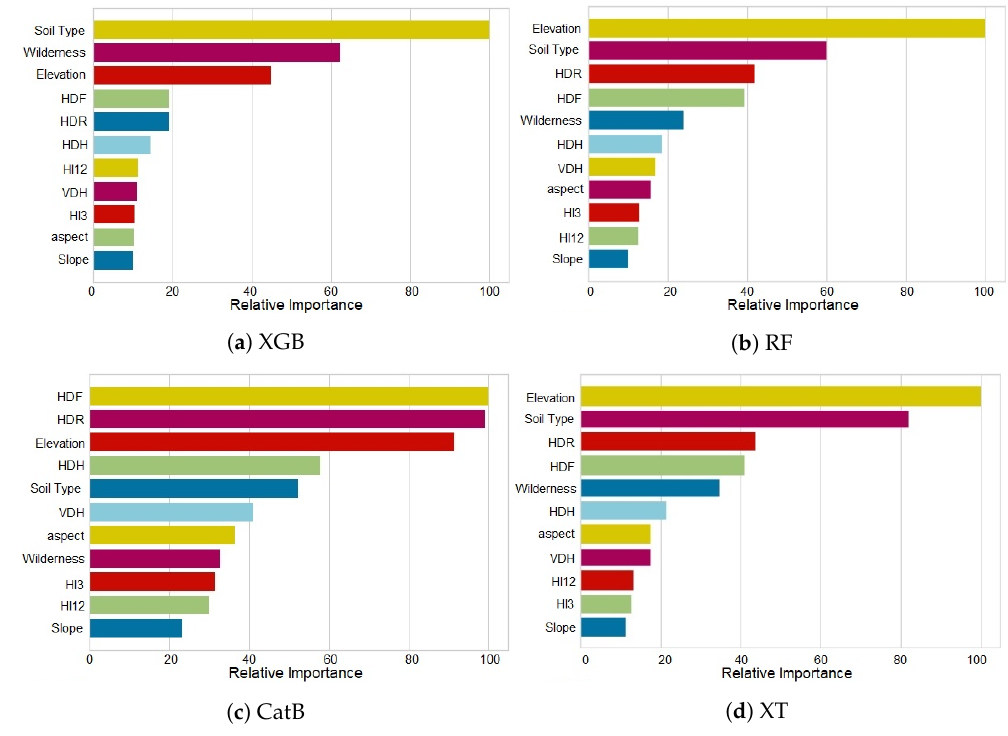
Figure 7. Relative importance of